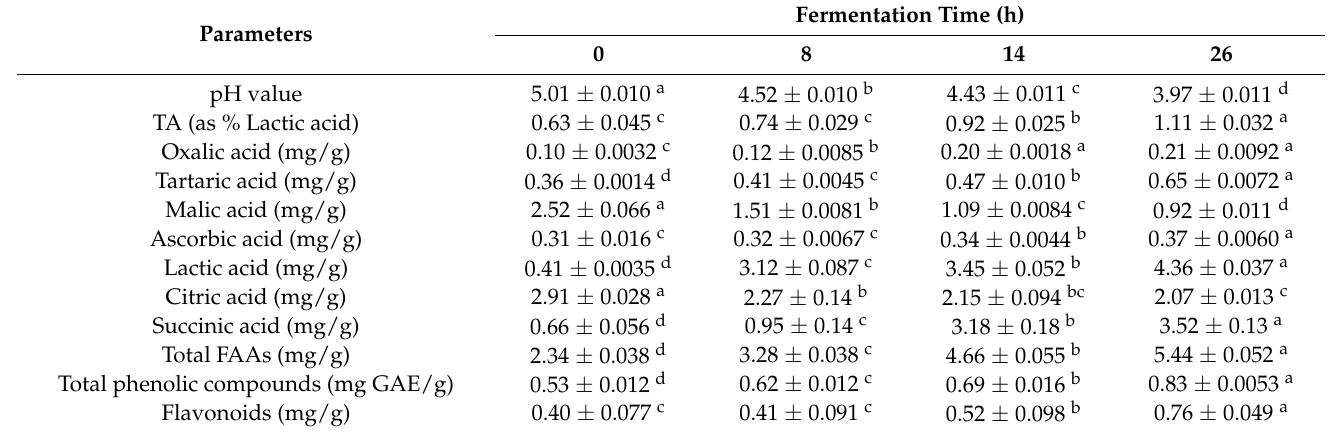
Table 1. Changes in pH value, TA and metabolites during pineapple waste–whey protein